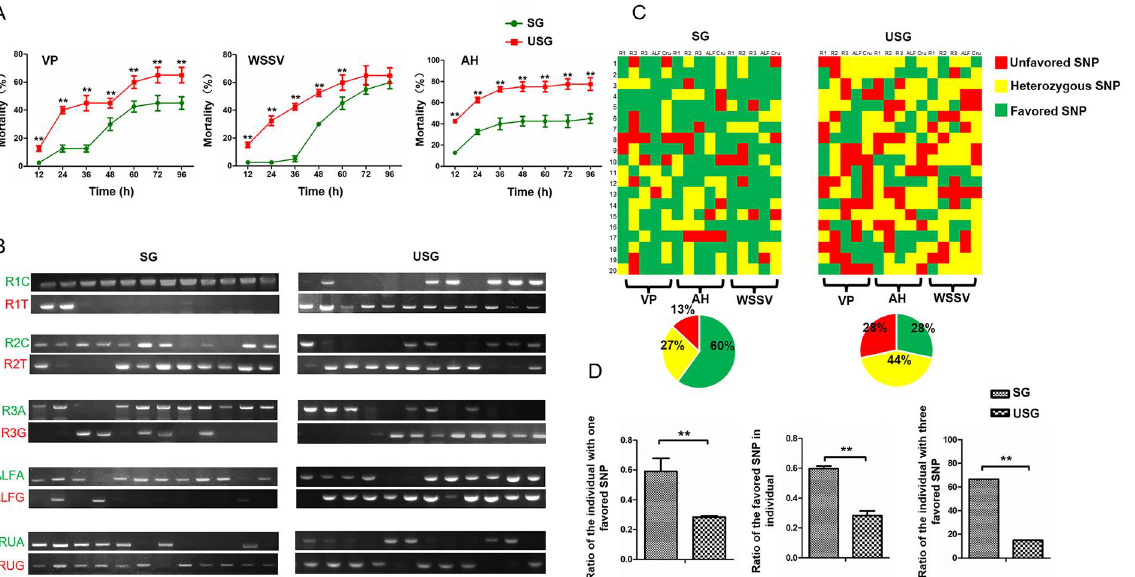
Figure 3. Genotypes and comparison of disease resistance of juvenile crayfish between selected group (SG) and unselected group (USG). ( A ) Mortality of juvenile crayfish challenged with Vibrio parahaemolyticus (VP), Aeromonas hydrophila (AH), and white spot syndrome virus (WSSV). ( B ) Elec- trophoresis gel images of PCR products to detect SNP (R1, R2, R3, ALF, and Cru) genotypes of SG and USG individuals. ( C ) Genotype diagram of SG and USG individuals; horizontal and vertical rows of rectangle represent different individuals and R1, R2, R3, ALF, and Cru SNP sites, respectively. ( D ) Ratio of favoured genotypes between SG and USG. ”**” indicates p <